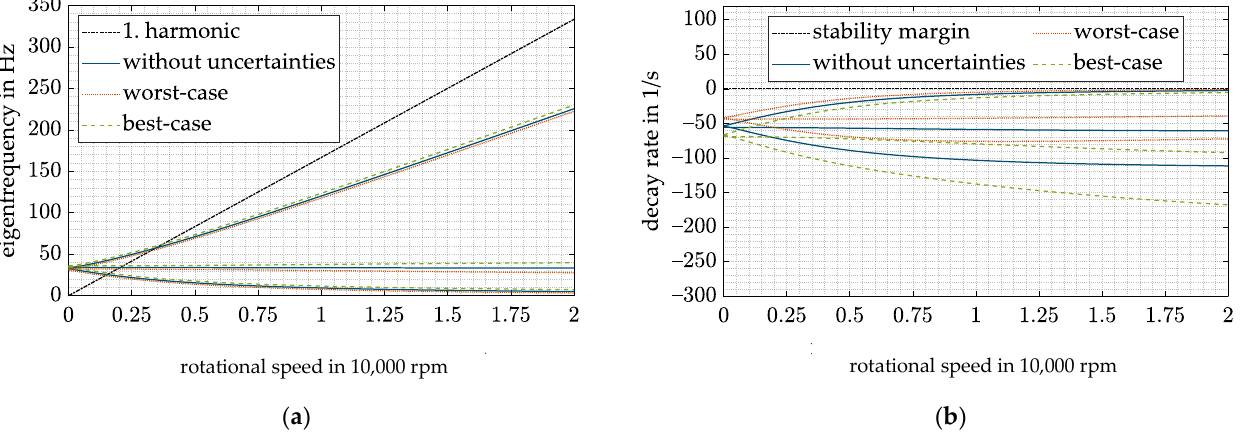
Figure 9. ( a ) Campbell diagram with DVFC; ( b ) decay rate with DVFC.